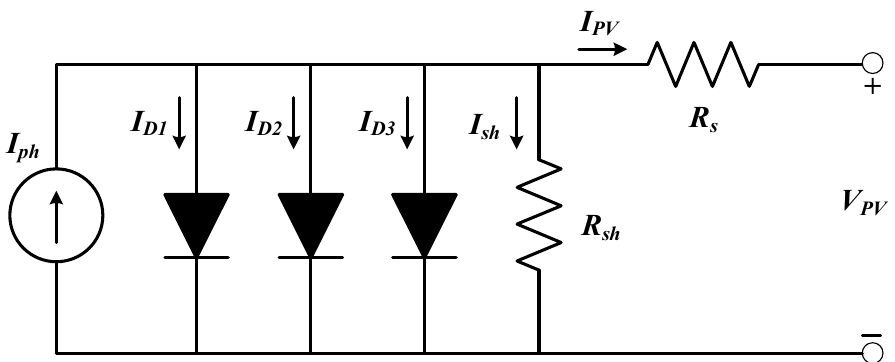
Figure 3. Circuit diagram of the triple diode model.